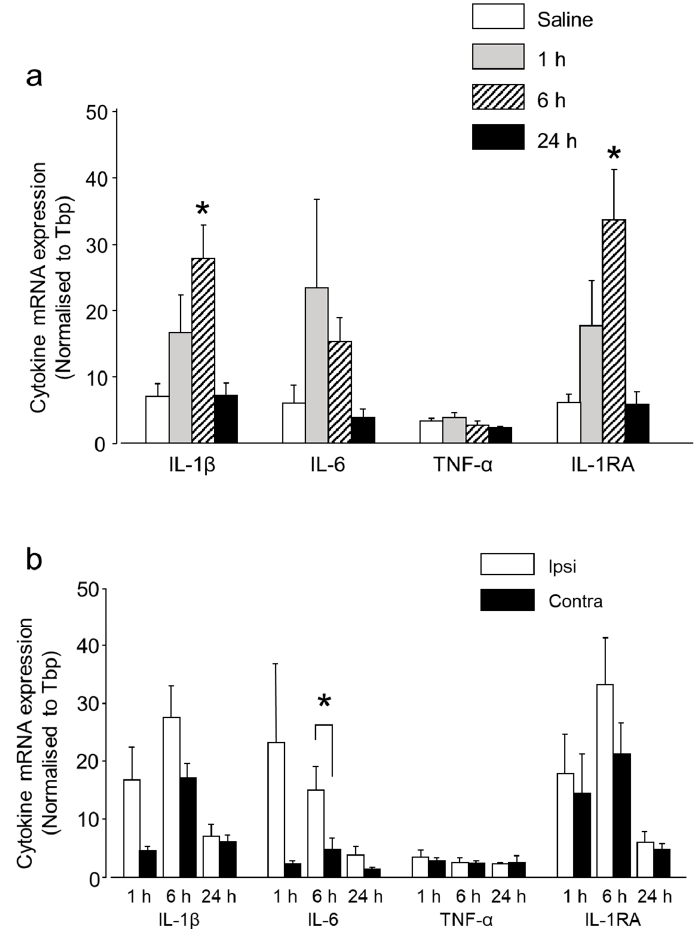
Figure 3. Differential mRNA expression of cytokines after IG CGRP administration. ( a ) IG CGRP increased the expression of IL-1 β , IL-6 and IL-1RA at 1 and 6 h after administration compared to the saline-injected group. However, the statistically significant result was observed only for IL-1 β and IL-1RA after 6 h. After 24 h, the expression of IL-1 β , IL-6 and IL-1RA decreased. TNF- α expression was similar in all the groups. #: p < 0.05 with one-way ANOVA followed by the Dunnett t test for comparison with saline injection. n = 5 rats were assigned to each group. ( b ) A comparison between ipsilateral and contralateral side showed increased expression on the injected side at 1 and 6 h for IL-1 β , IL-6 and IL-1RA. However, statistically significant result was observed only for IL-6 at 6 h using one-way ANOVA, *: p < 0.05, n = 5 in each